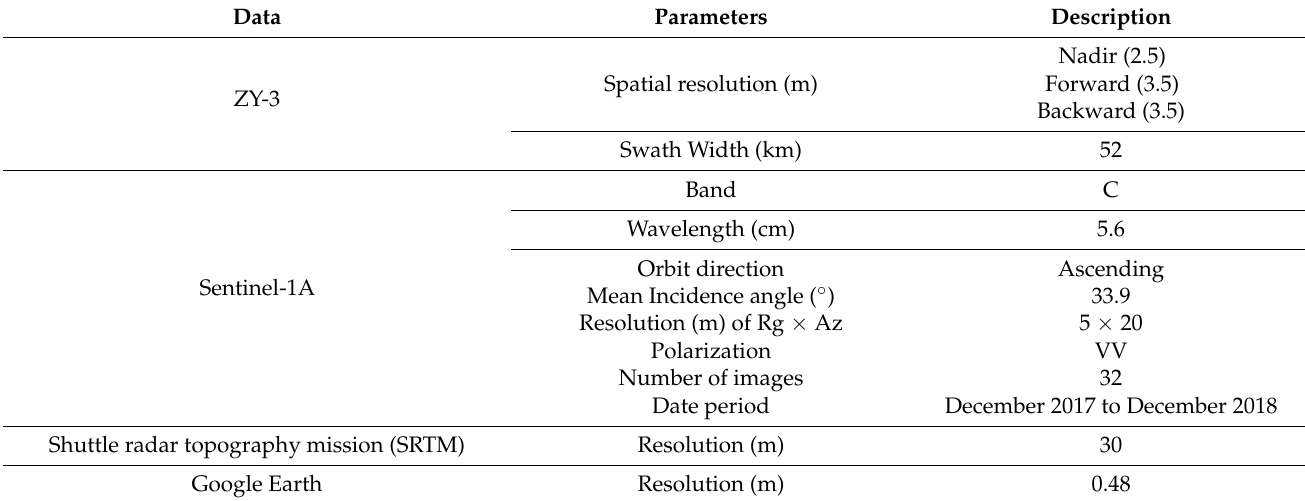
Table 1. Detailed information on the datasets used in this